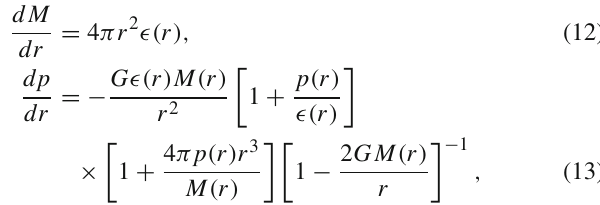
Fig. 3 Quark fractions as functions of the baryon density in SQM with g-2, g-3, g-4, and g-5 in different temperature cases